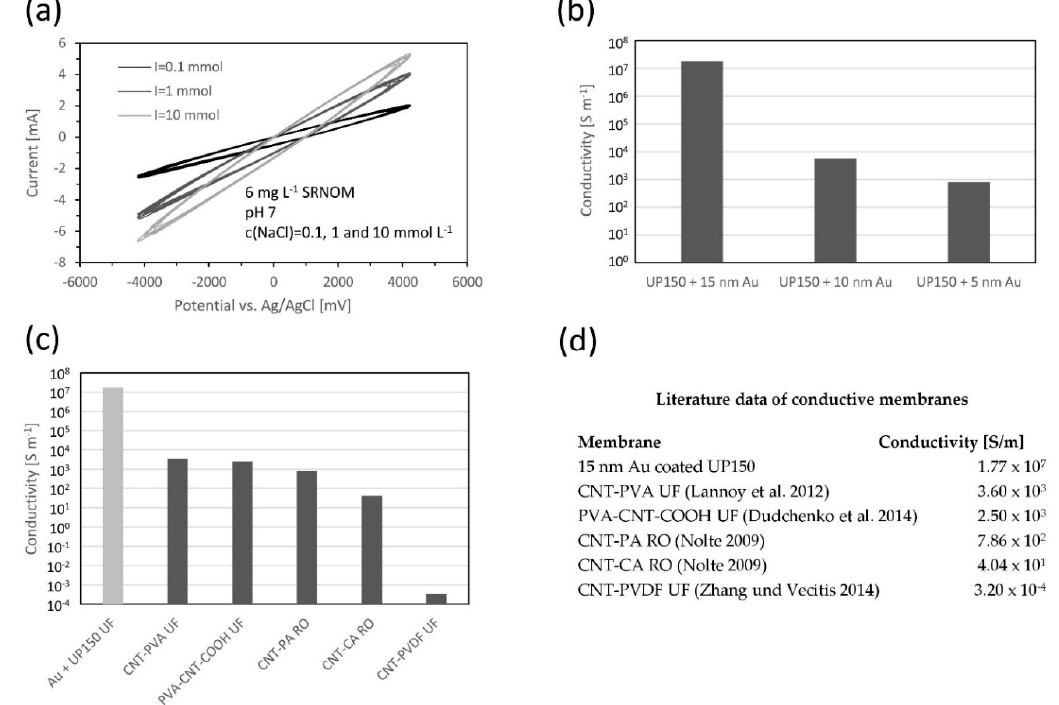
Figure 4. Electrochemical characterization of membrane: ( a ) cyclic voltammetry of Au coated UP150 in Suwannee River Natural Organic Matter (SRNOM) solution of 6 mg L − 1 at 0.1, 1 and 10 mmol L − 1 NaCl (scan rate 100 mV s − 1 ); ( b ) surface conductivity vs. thickness of gold layer; ( c ) surface conductivity vs. literature values of CNT membranes; ( d ) literature data of conductive membranes.